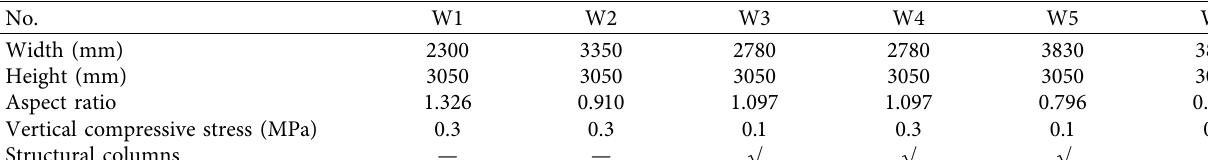
Table 5: Design of fired shale hollow block masonry walls.